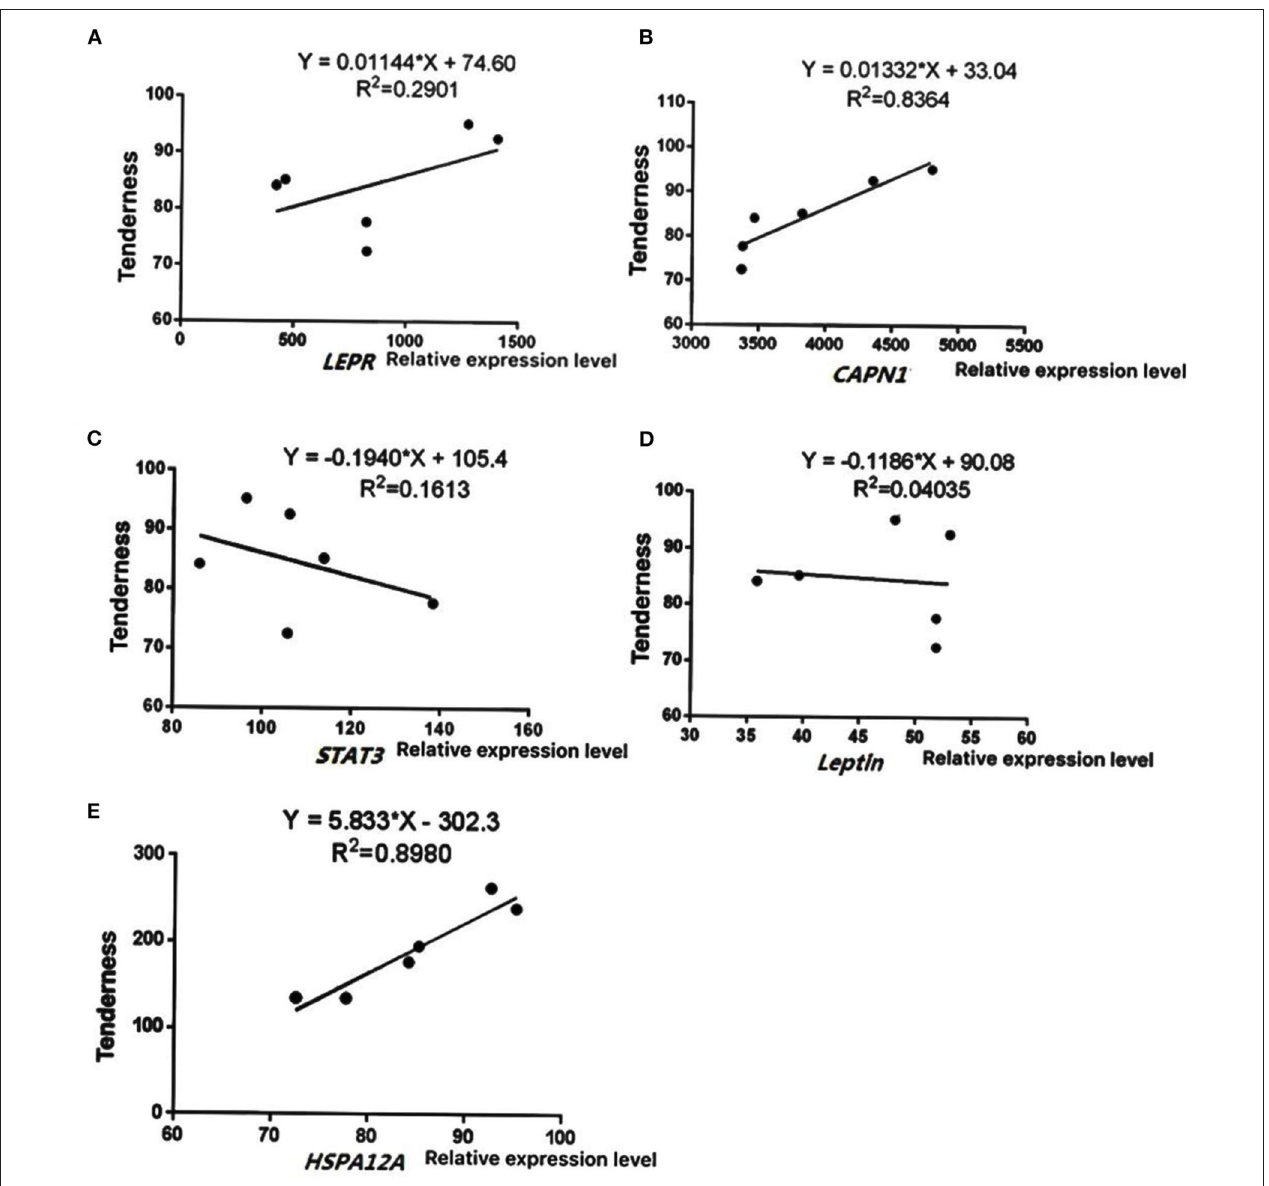
FIGURE 6 | Correlation analysis between gene expression levels and tenderness. Data were presented as means ± SD of at least three independent experiments. (A) The correlation analysis between LEPR levels and muscle shear. (B) The correlation analysis between CAPN1 levels and muscle shear. (C) The correlation analysis between STAT3 levels and muscle shear. (D) The correlation analysis between Leptin levels and muscle shear. (E) The correlation analysis between HSPA12A levels and muscle